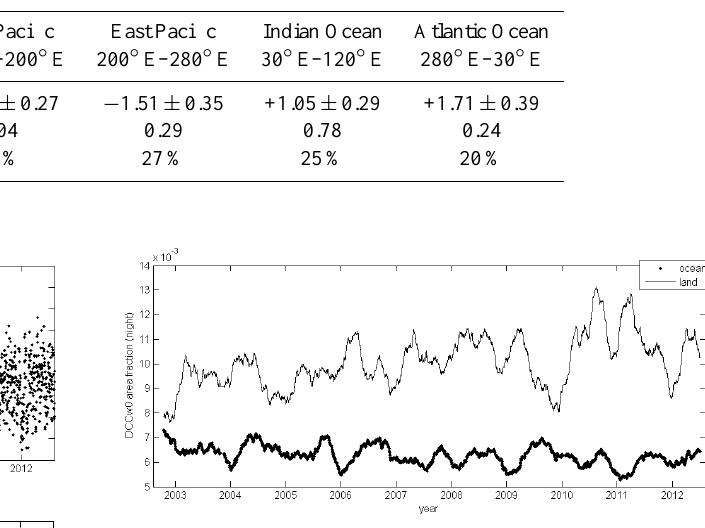
Table 4. Trends for tropical oceans.